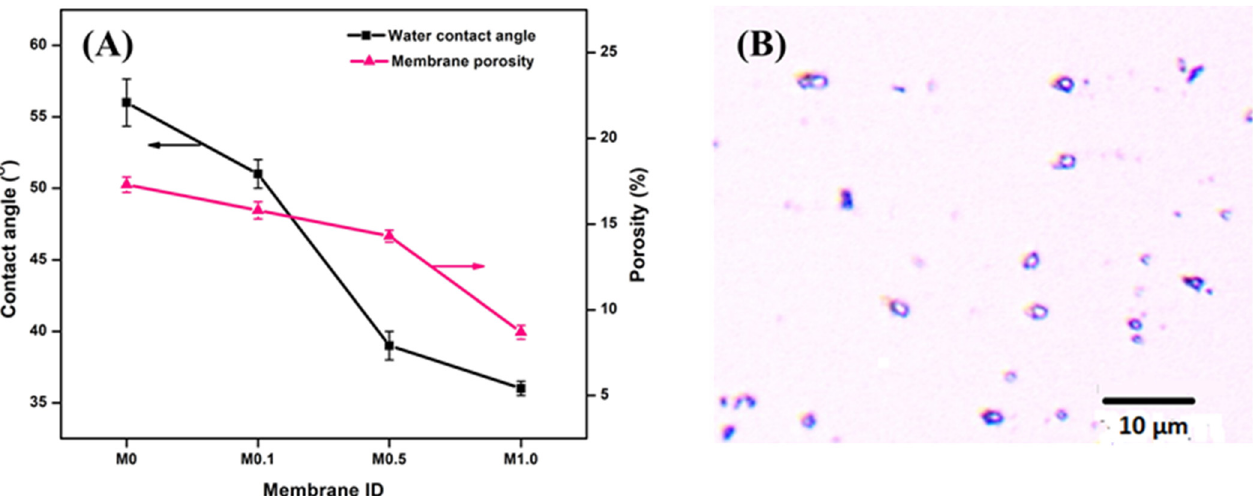
Figure 6 . ( A ) Contact angles and porosity of pristine and coated membranes and ( B ) Optical micros- copy image of o/w emulsion